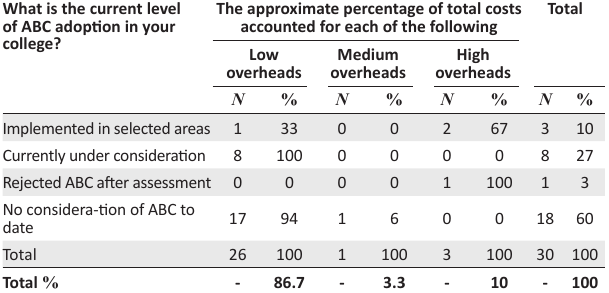
TABLE 3: Overheads and involvement of colleges in activity-based costing adoption.